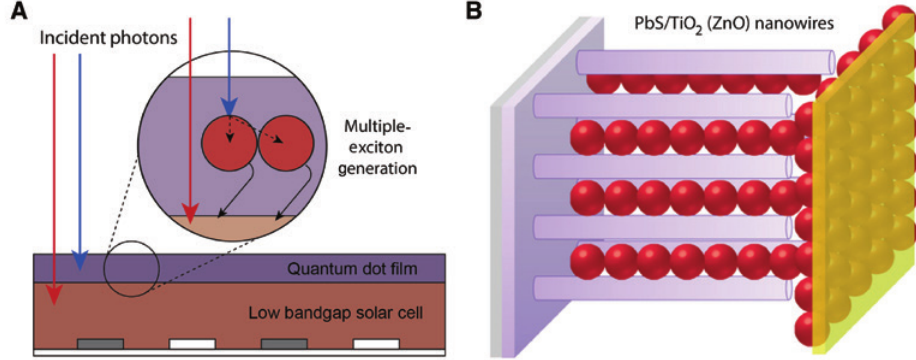
Figure 7: Potential methods for upgrading state-of-the-art solar cells utilising carrier multiplication in quantum dots. Schematics of (A) an MEG-enhanced, interdigitated bottom-contact solar cell [132]. High-energy photons (blue arrows) are absorbed in the thin QD layer processed on top of a bulk semiconductor where they can undergo MEG. The carriers from the generated multi-exciton state are subsequently transferred to the low band gap semiconductor and can contribute to the photocurrent. Meanwhile, photons of lower energy are more likely to pass through the QD film due to the lower absorption cross-section and can be absorbed and converted into charge carriers in the bulk semiconductor. (B) A device concept based upon a nanostructured hetero-interface between QD absorber and metal oxide acceptor. Here most multiple-exciton states are generated close to an ionising interface. Both an efficient harvest of multi-exci- ton states and long optical path lengths for absorbing solar photons are possible. Part B is taken from